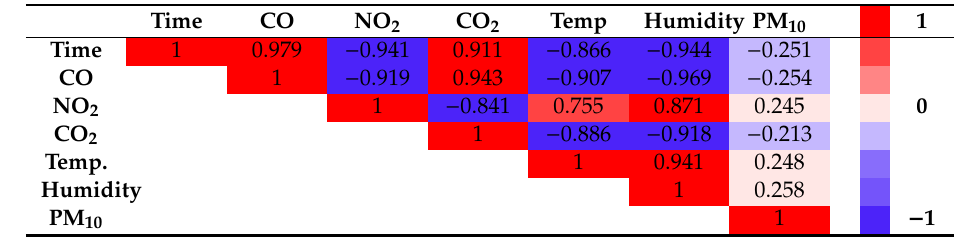
Table 3. Linear correlation matrix for period 1.